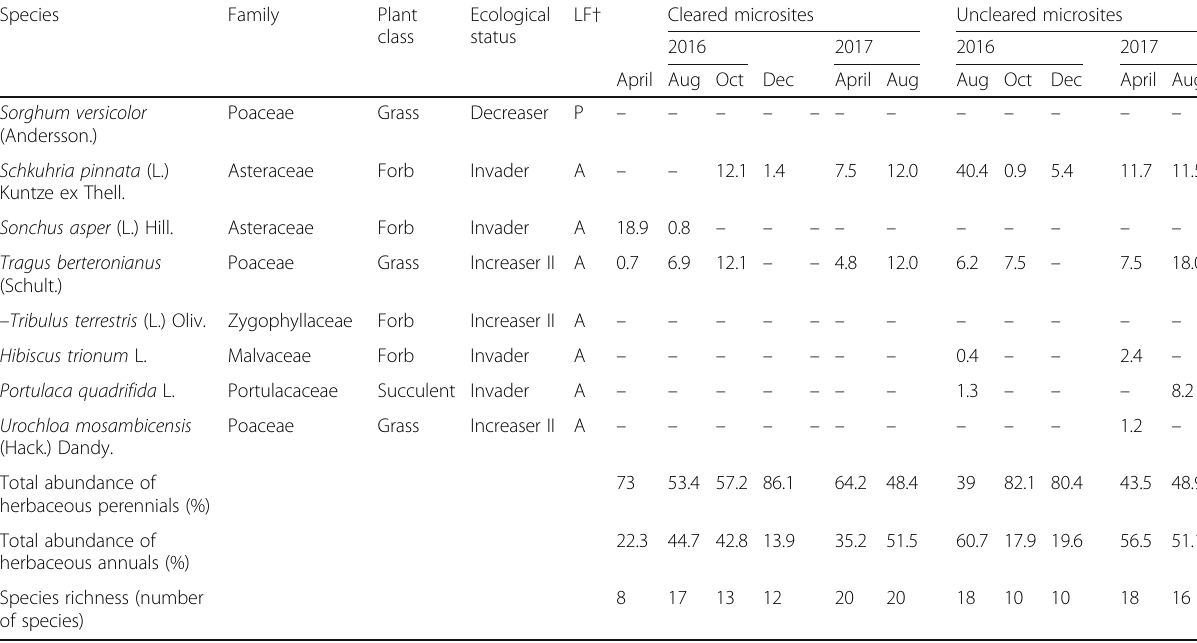
Table 1 Plant species abundance (%) and richness of the soil seed bank over time in bush-cleared and uncleared microsites